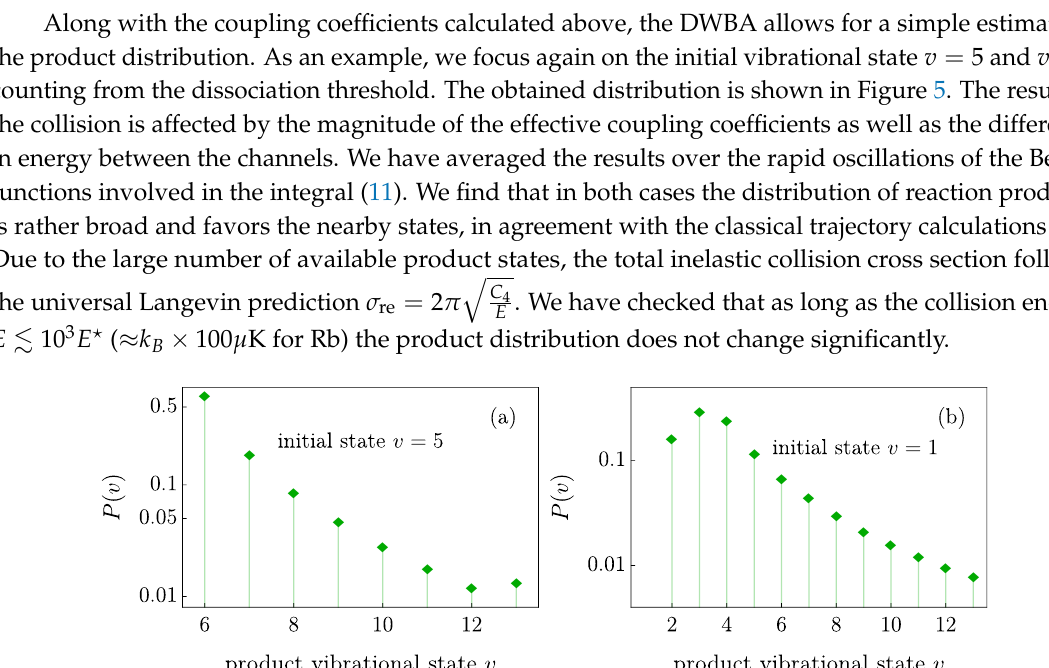
Figure 4. K matrix elements calculated within the distorted wave Born approximation (DWBA) for vanishing collision energy as a function of the energy difference between the channels for the entrance channel scattering length a = R (cid:63) and initial kinetic energy E = 10 − 4 E (cid:63) .